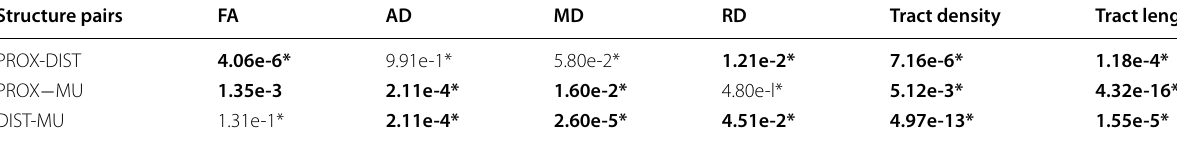
Table 4 Tukey’s test (or the nonparametric Dunn’s test *) p values for the DTI metrics comparison between each pair of regions: proximal sphincter (PROX) vs. distal sphincter (DIST); proximal sphincter (PROX) vs. membranous urethra (MU); distal sphincter (DIST) vs. membranous urethra (MU). Statistically significant results are highlighted in bold Structure